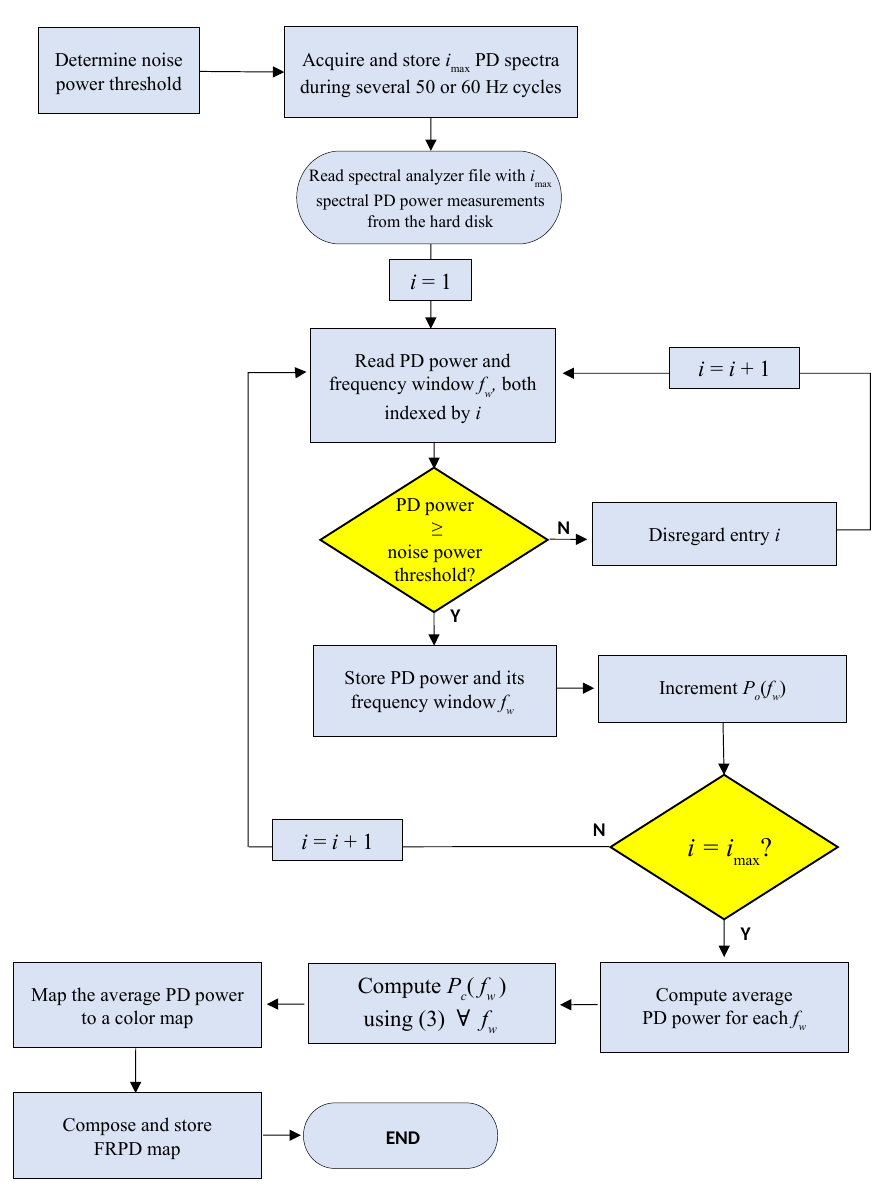
Figure 10. Algorithm for the proposed FRPD methodology. In this work, i max =